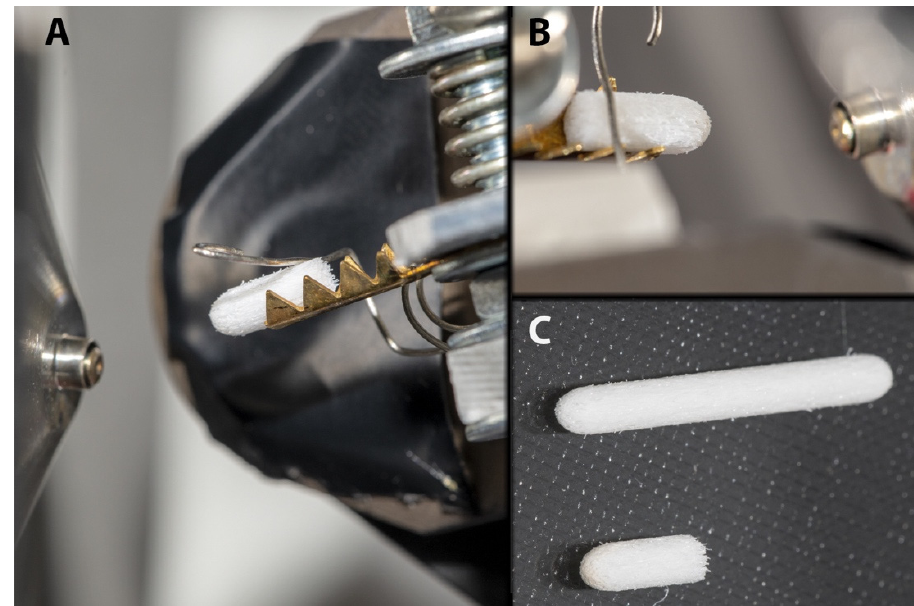
Figure 1. Experimental setup of sampler probe as an ion source. A sampler probe with 10.0 mm length was placed into a brass holder and fixed with a stainless-steel clamp ( A , B ). 10.0 mm long sampler probe ( C , bottom) was made by cutting commercially available felt-pen tip ( C , top).